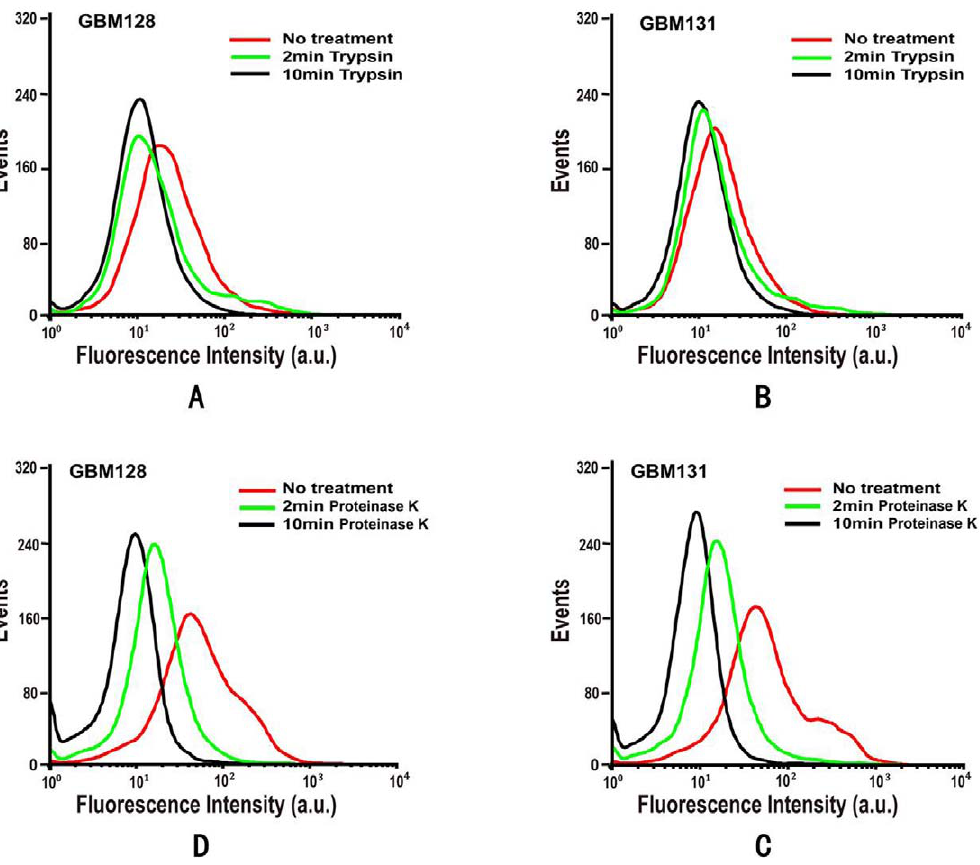
Figure 3. Binding affinity of aptamers GBM128 and GBM131 to trypsin or proteinase K treated U118-MG cells. After 2 min and 10 min trypsin or proteinase K treatment, the binding of GBM128 and GBM131 was apparently affected by trypsin digestion but totally quenched by